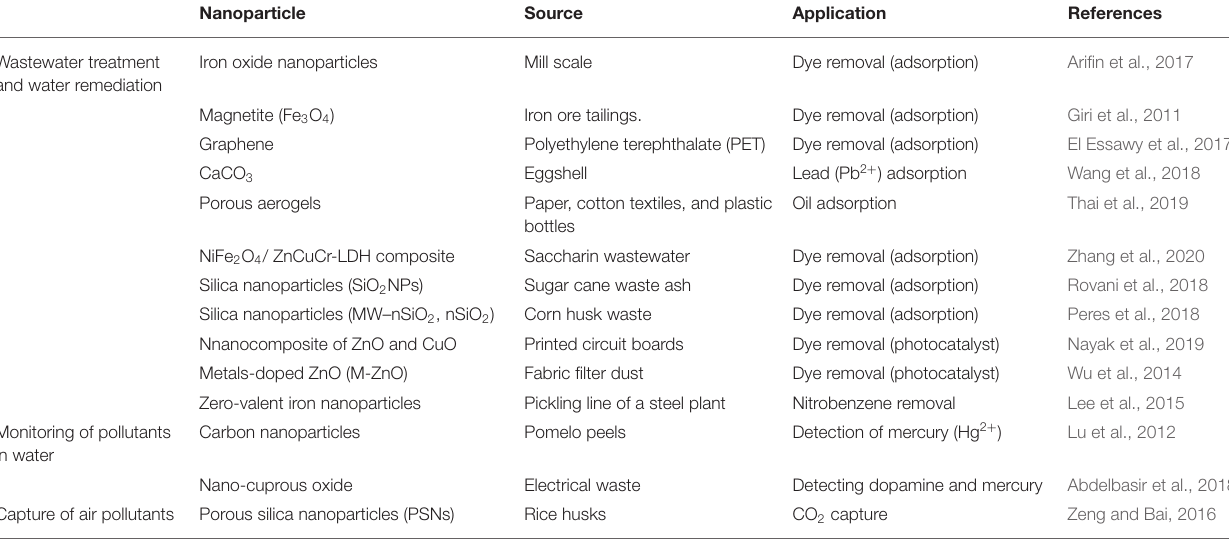
TABLE 6 | Environmental applications of waste